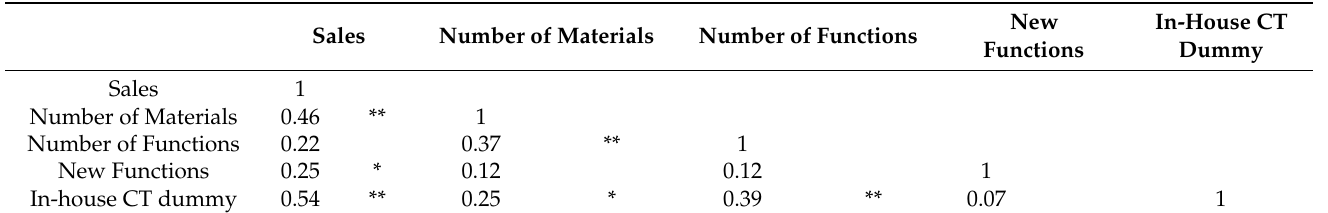
Table 7. Correlation coefficients between indicators for 74 foods with function claims (FFC) products.